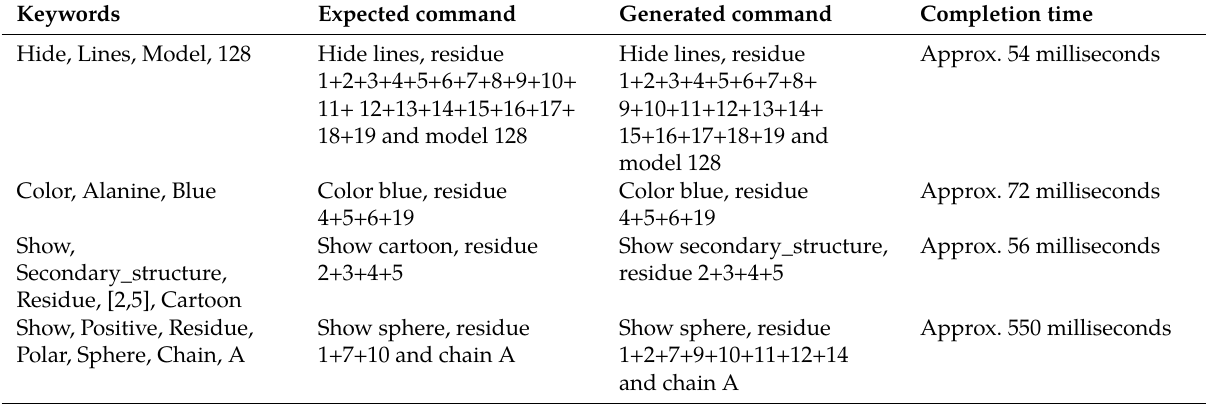
Table 2: Example of commands used to evaluate performance of the inference engine for voice